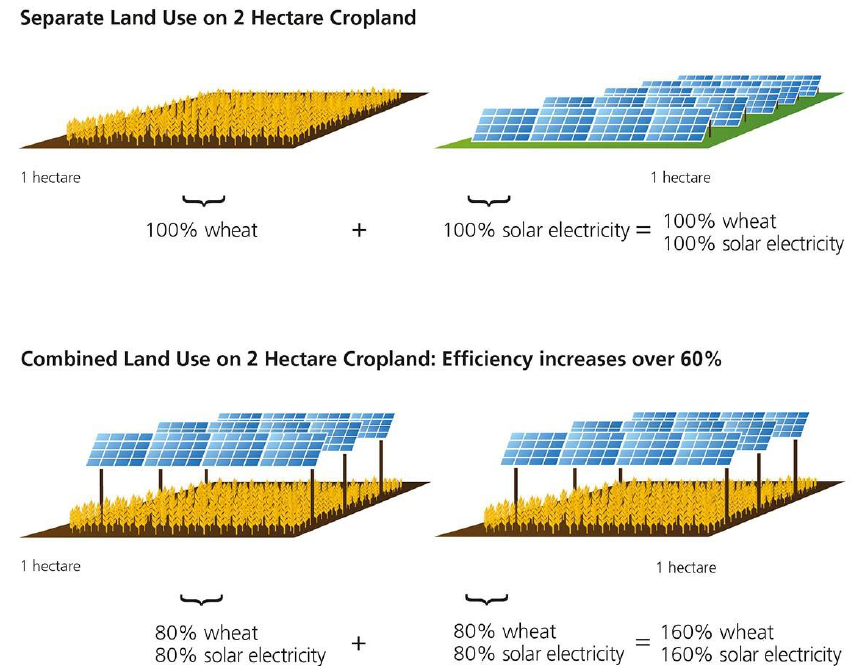
Figure 2. Comparison of land use for separate and combined agriculture and PV systems. Source: Reprinted with permission [20]. Copyright {2021}.